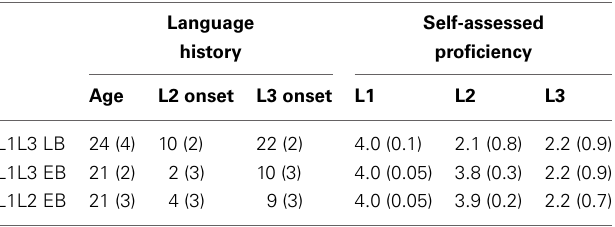
Table 1 | Language history and self-assessed proficiency for the three groups of